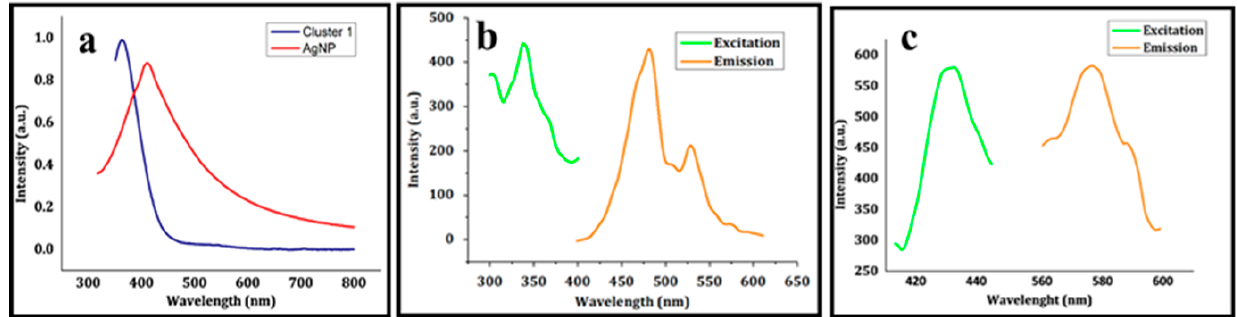
Figure 3. ( a ) Electronic absorption spectrum of cluster 1 (Blue) and AgNPs (red). ( b ) Excitation spectrum of AgNPs (green) and emission spectrum (orange). ( c ) Excitation spectrum of cluster 1 (green) and emission spectrum (orange).